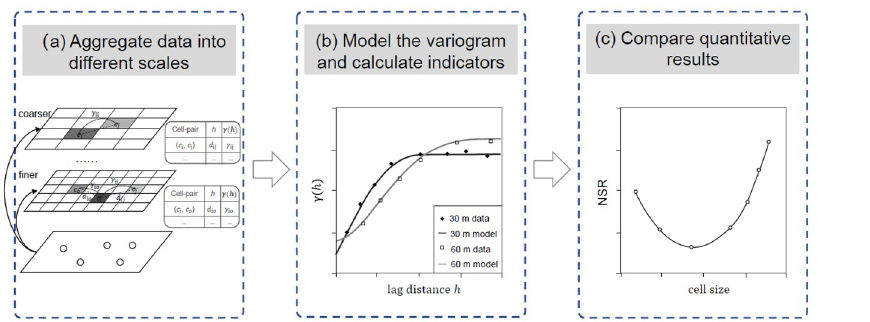
Fig 2. Process of quantifying the scale effect with a